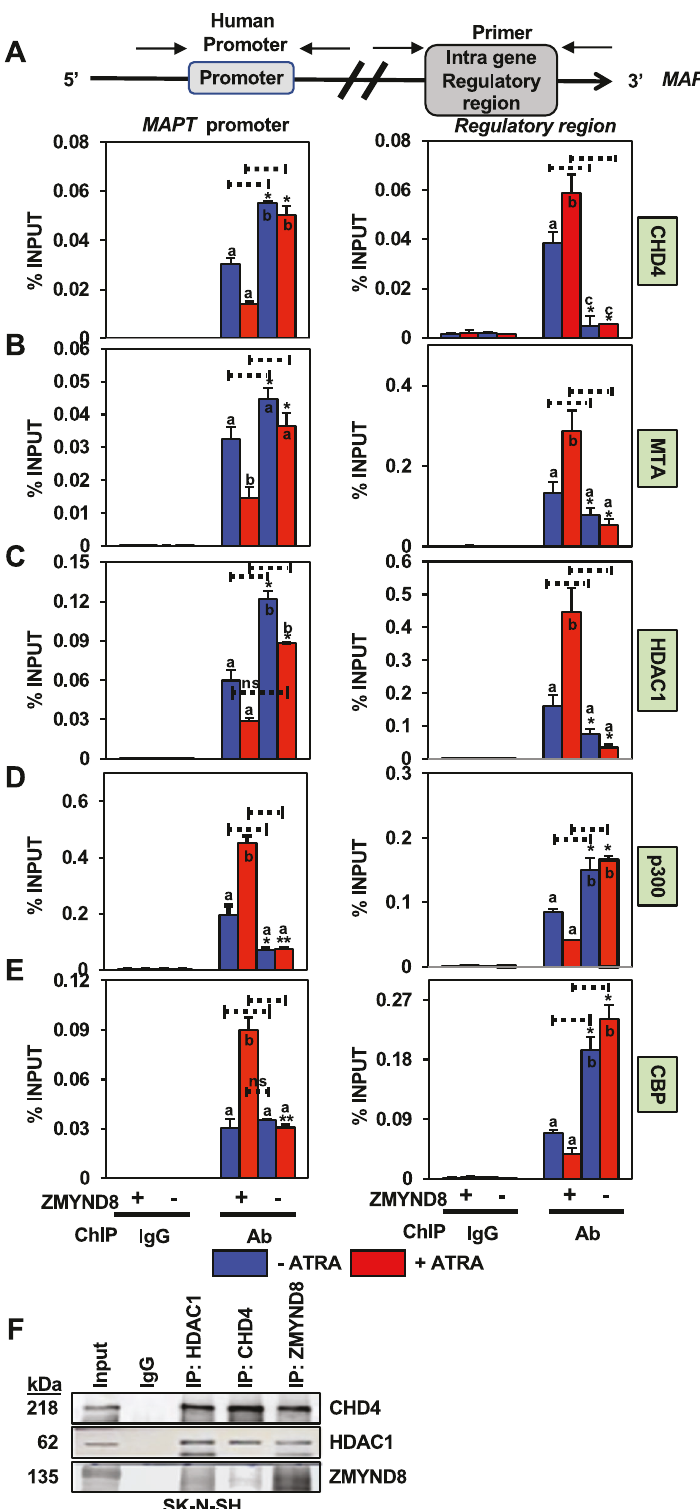
Fig. 5 ZMYND8 is associated with the transcription repressor complex at the MAPT intra-regulatory region. A – E Bar plots of qPCR showing enrichment of CHD4 ( A ), MTA1 ( B ), HDAC1 ( C ), p300 ( D ), and CBP ( E ) at the MAPT promoter and IGRR in ZMYND8 -knockout ( ZMYND8 -KO) or control SK-N-SH cells with or without ATRA treatment. Error bars indicate sem.; n = 3; three independent experiments. A two-tailed t -test was used to calculate P -values. * P < 0.05; ** P < 0.01. One-way ANOVA was used to compute statistical differences. Boxes marked with a, b, and c are signi fi cantly different from each other padj-value = <0.05. F Coimmunoprecipitation showing ZMYND8 associates with NuRD subunits (HDAC1 and CHD4) and vice versa.